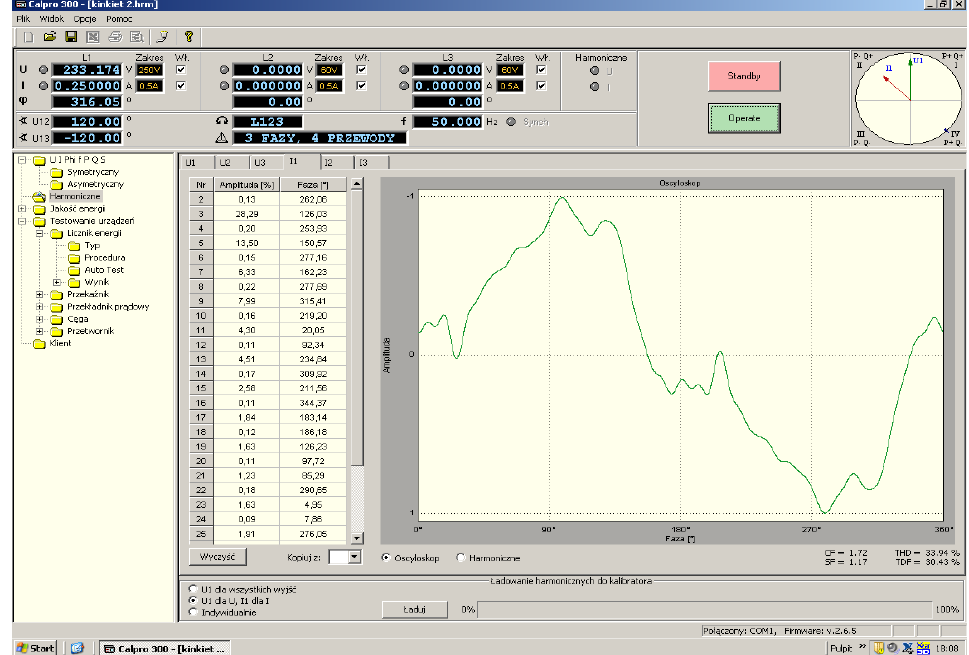
Figure 4. Window of the CALPRO 300 software, in which an example of a distorted current (generated from the CALPRO software) is shown.